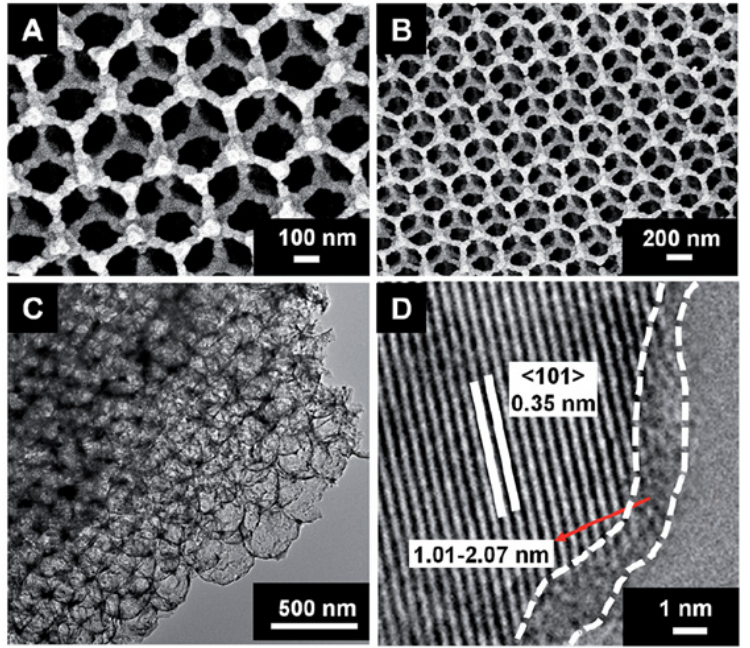
Figure 11. ( A , B ) FE-SEM, ( C ) TEM, ( D ) HR-TEM images of black TiO 2 inverse opals. Reprinted with permission from [74]. Copyright 2015, Royal Society of Chemistry.